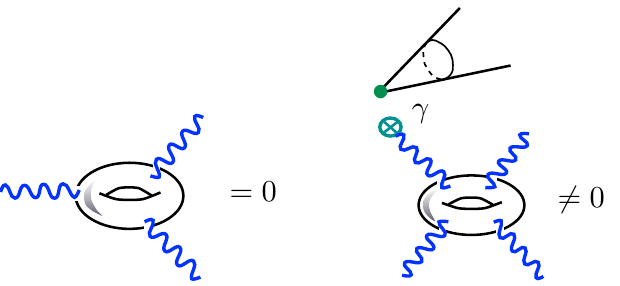
Figure 7 . A schematic picture of minahaning as background (cid:12)eld